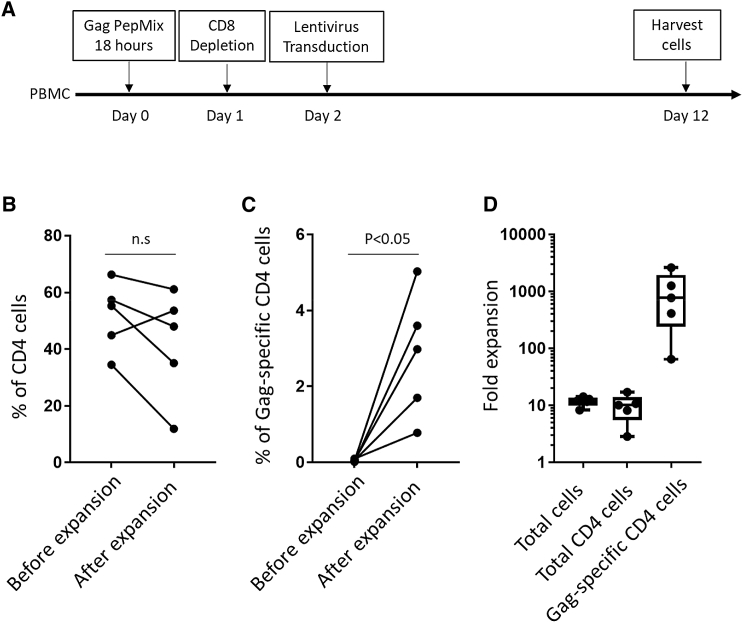
Expansion of HIV Gag-Specific CD4 T Cells by Peptide Stimulation and CD8 T Cell Depletion(A) Experimental design to expand HIV Gag-specific T cells. (B and C) The percentage of CD4 (B) and Gag-specific CD4 T cells (C) before and after expansion. Paired T Tests were performed. All tests were two-tailed and P values of P<0.05 were considered significant. (D) Fold expansion of total cells, total CD4 T cells, and HIV Gag-specific CD4 T cells. Boxplots show all points (min to max) and mean.